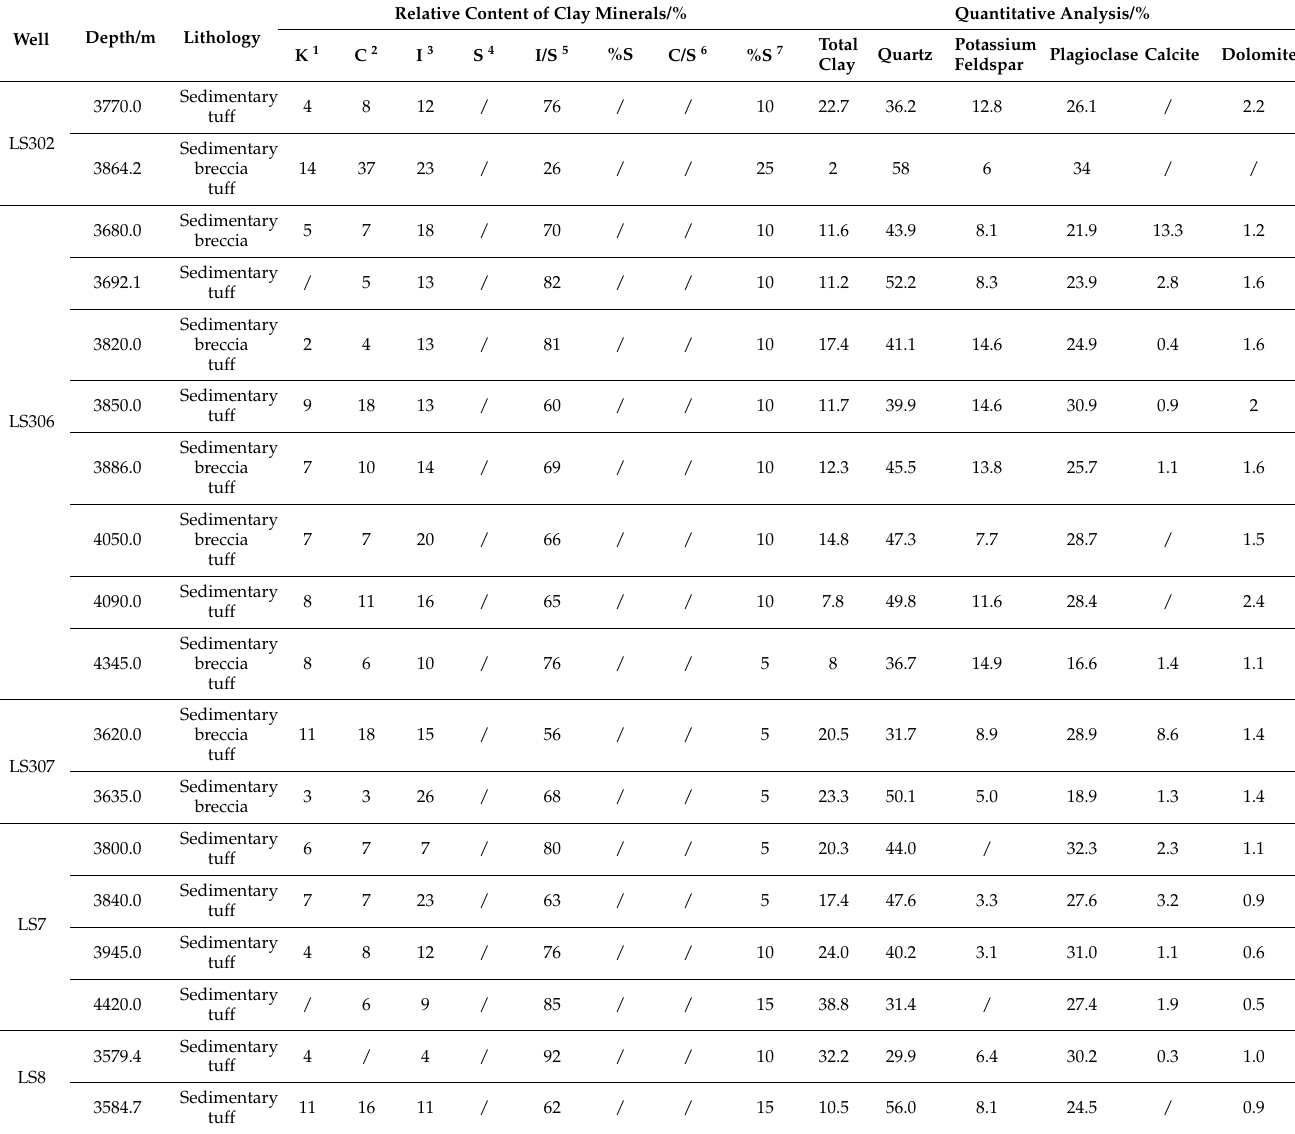
Table 2. Data of XRD for sedimentary pyroclastic rocks in K 1 y 2 ,